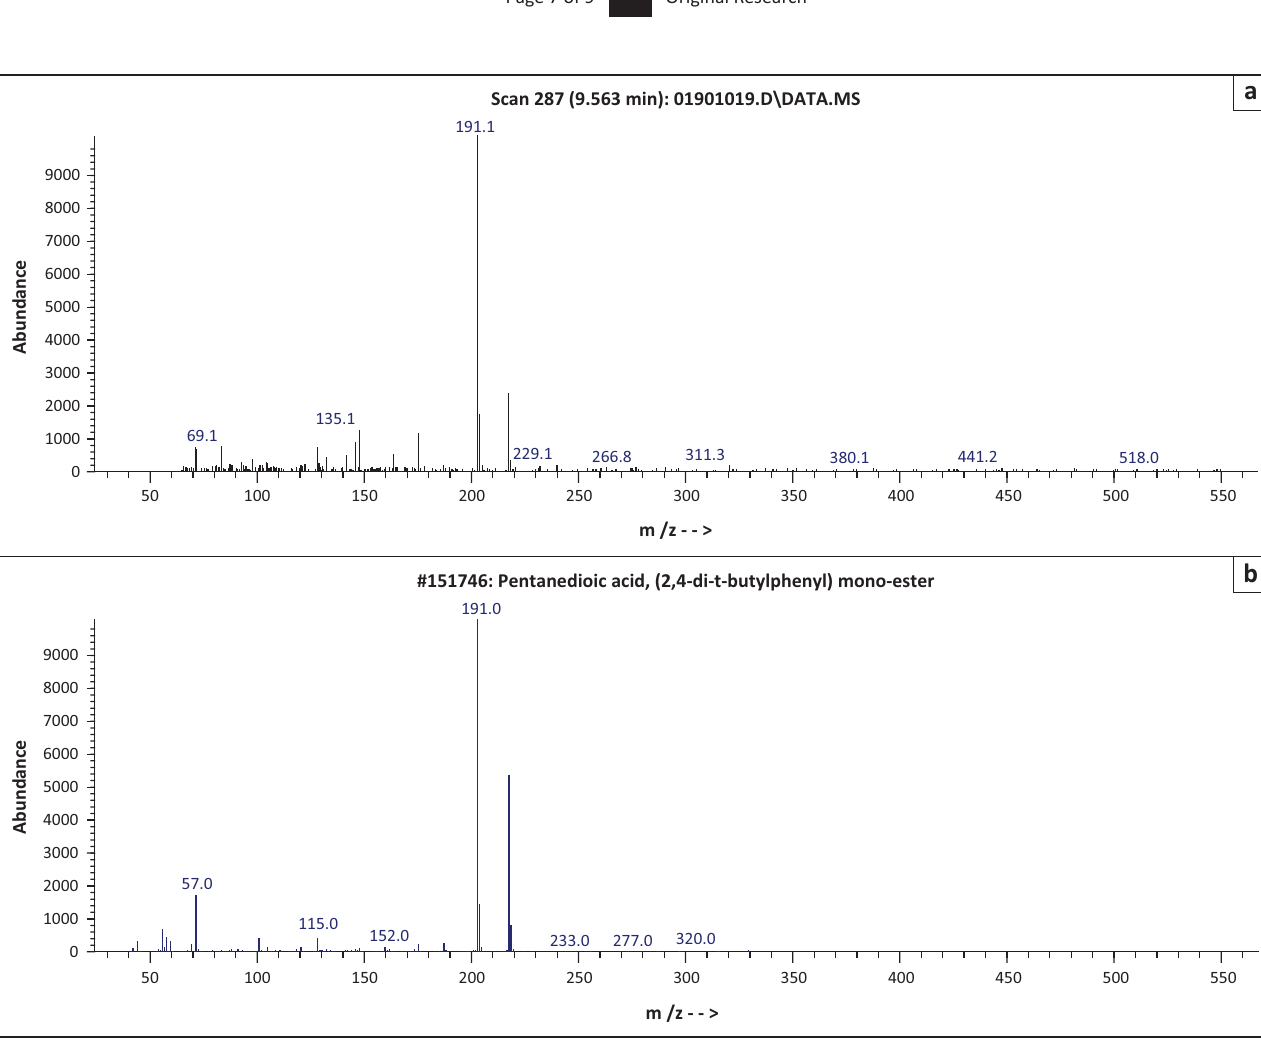
FIGURE 6: Gas chromatography – mass spectrometer spectra of pentanedioic acid monoester.